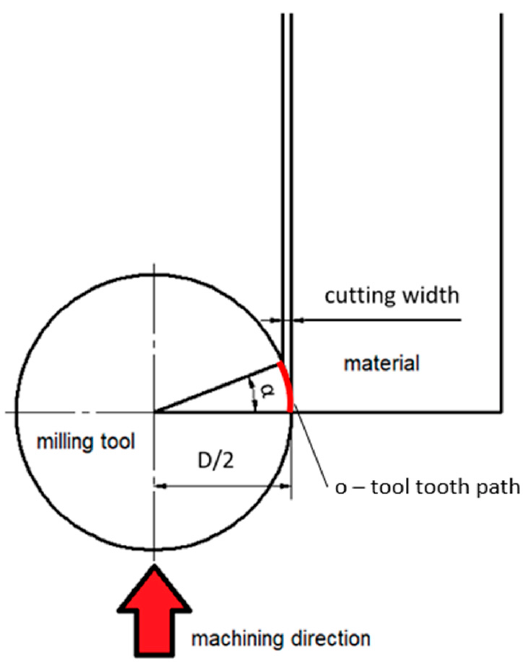
Figure 4. Scheme for calculating the tool tooth path.